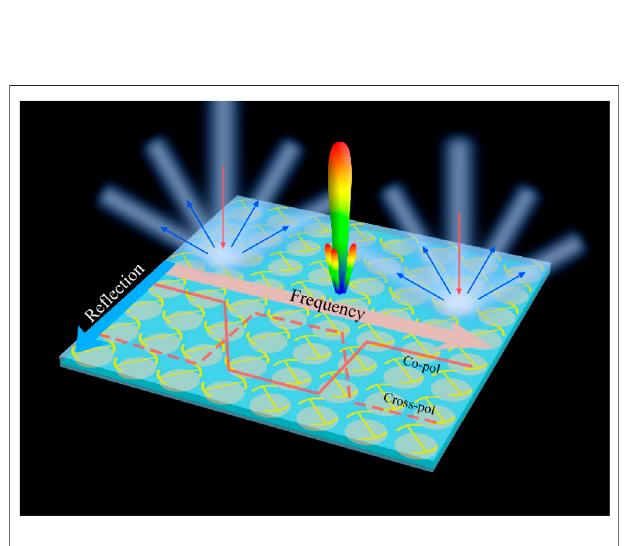
FIGURE 2 | Diagram of the proposed